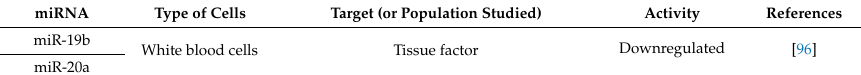
Tissue factor, Plasminogen activator inhibitor, Monocyte chemoattractant protein, Vascular endothelial growth